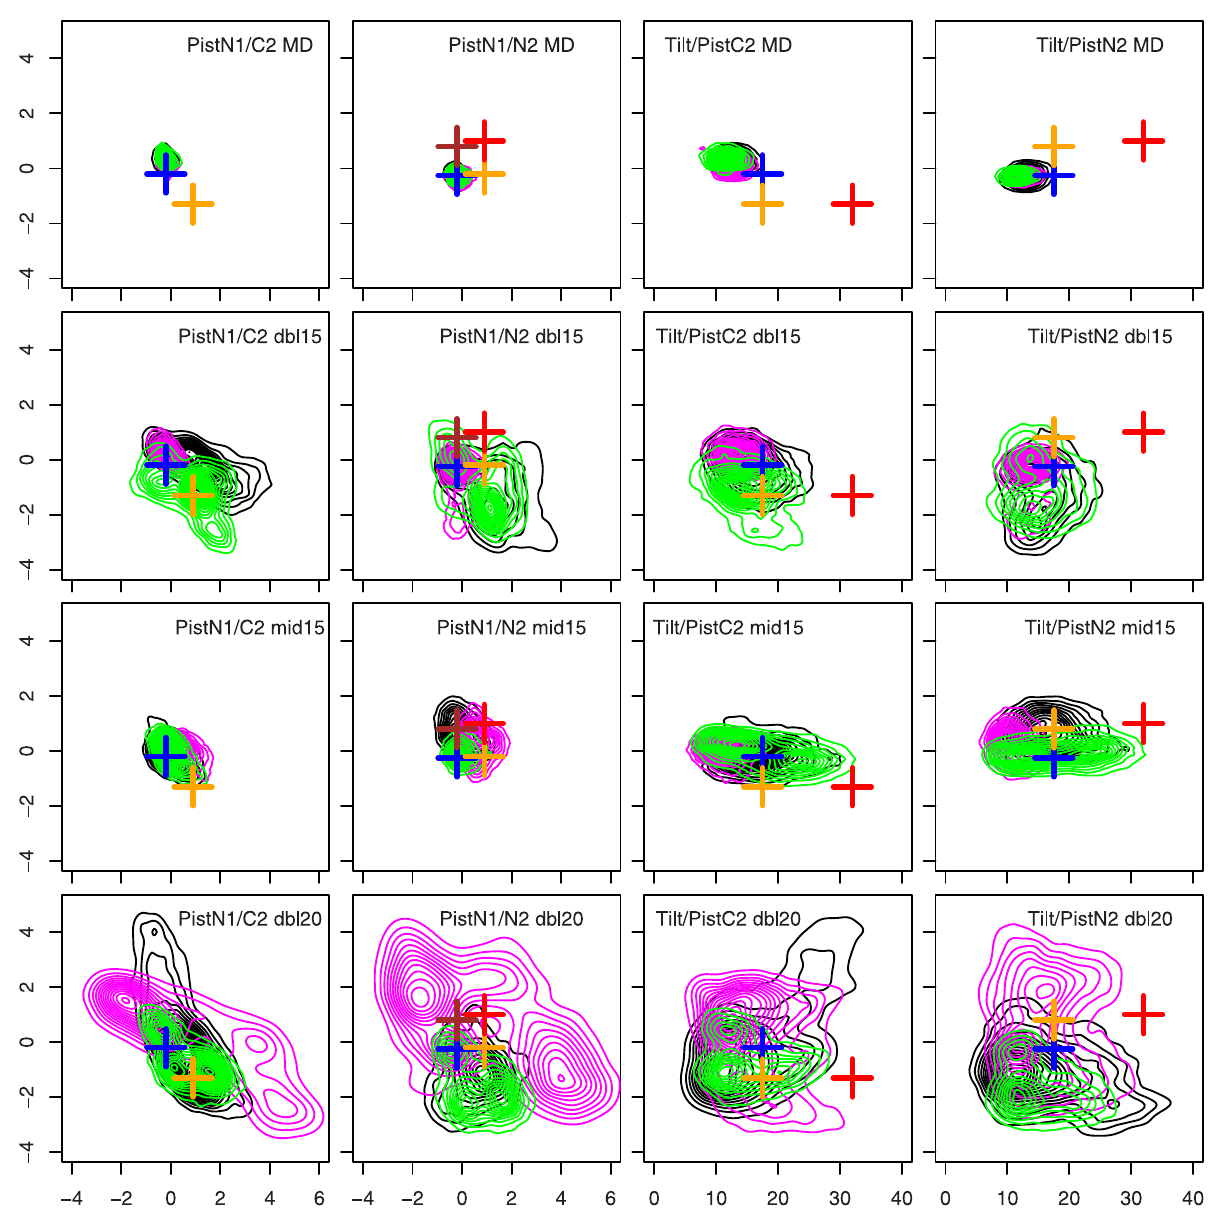
Fig 3. Relative motions of HAMP α helices. Contour plots describing the distribution of piston (Eq 5) and average tilt (Eq 7) along MD and TAMD trajectories dbl15, mid15 and tet20. Each plot is labeled XYT, where X and Y correspond to the x and y axis labels and T to the trajectory name. N1 and C2 refers to the names of HAMP helices given in Fig 1. The positions of the parameters for the representative conformations proposed by Zhu et al [41] on the isolated HAMP are displayed as crosses: P00 (blue), P01 (brown), P10 (orange) and P11 (red). On the plots Piston N1/C2, P00/P01 and P10/P11 are superimposed and only P00 and P10 are plotted. On the plots Average Tilt/Piston C2 and Average Tilt/Piston N2, P00/P01 are superimposed and only P00, P10 and P11 are